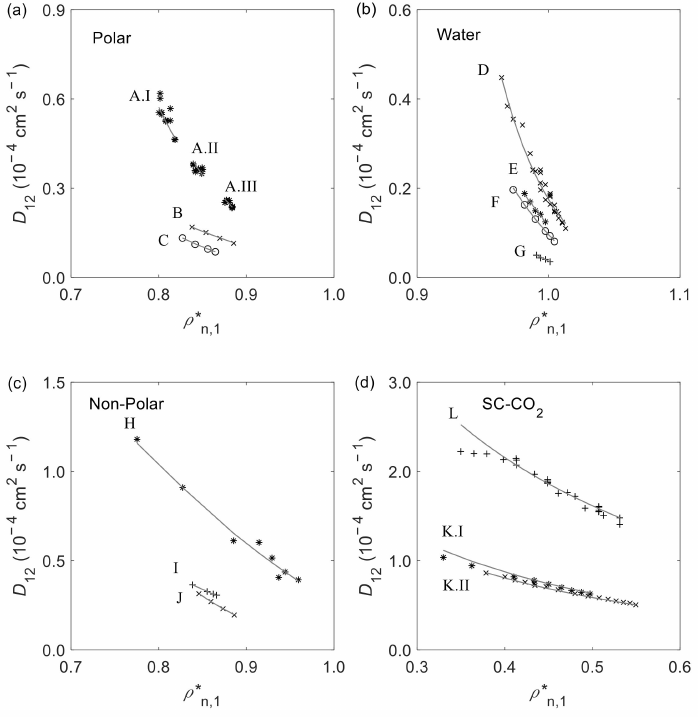
Figure 5. Representation of experimental (mark) and predicted (line) D 12 values vs. reduced number density of the solvent ( ρ ∗ ), at fixed T or P , for systems with: ( a ) polar solvents excluding water; n,1 ( b ) water as solvent; ( c ) non-polar and weakly polar solvents, excluding SC-CO 2 ; and ( d ) SC-CO 2 as solvent. The letters identify the following systems: A—ethanol/propane at 348.15 K (I), 323.15